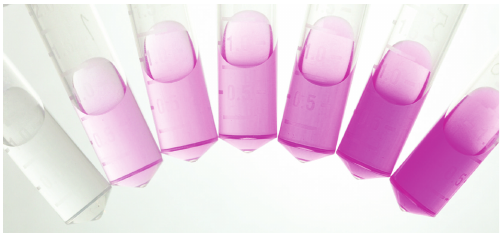
Figure 1: Increments to 0.1 µ L (more left) to 0.7 µ L (more right) added in 1.3 mL of the distillated water were used to compose the absorbance curve. The start point for this curve was the absorbance value of the water without addition of the color